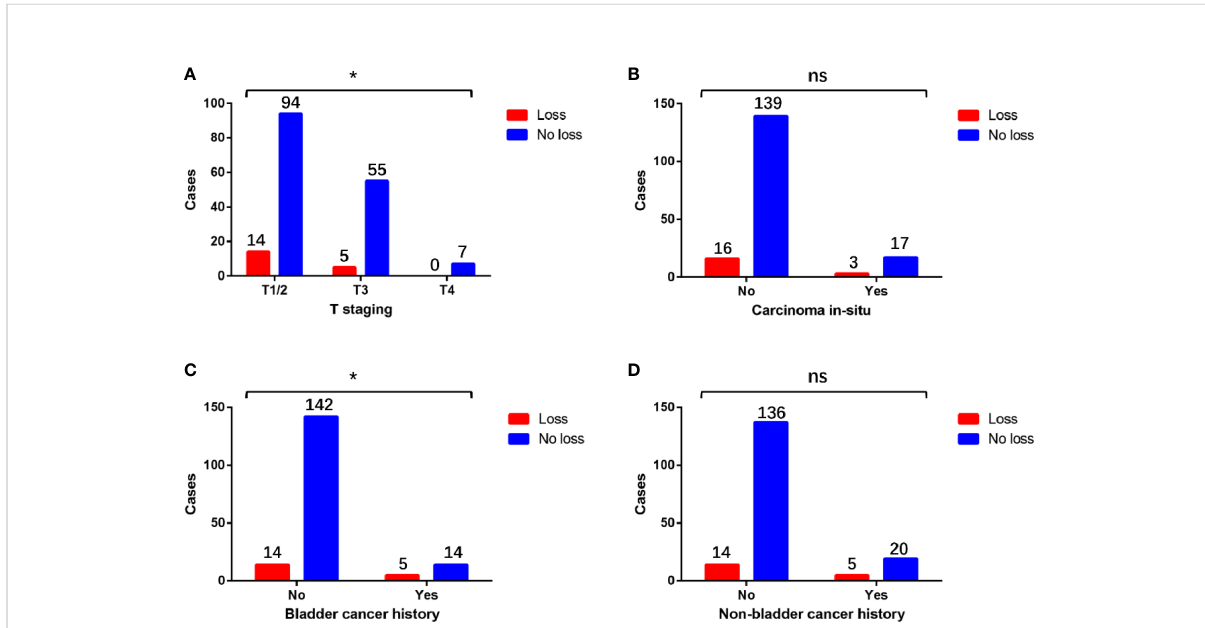
FIGURE 3 Differences in the distribution of the loss of MMR protein expression in patients with different (A) T staging, (B) carcinoma in situ status, (C) bladder cancer history, and (D) non-bladder cancer history. * means P<0.05, which is statistically signi fi cant. “ ns ” means not statistically signi fi